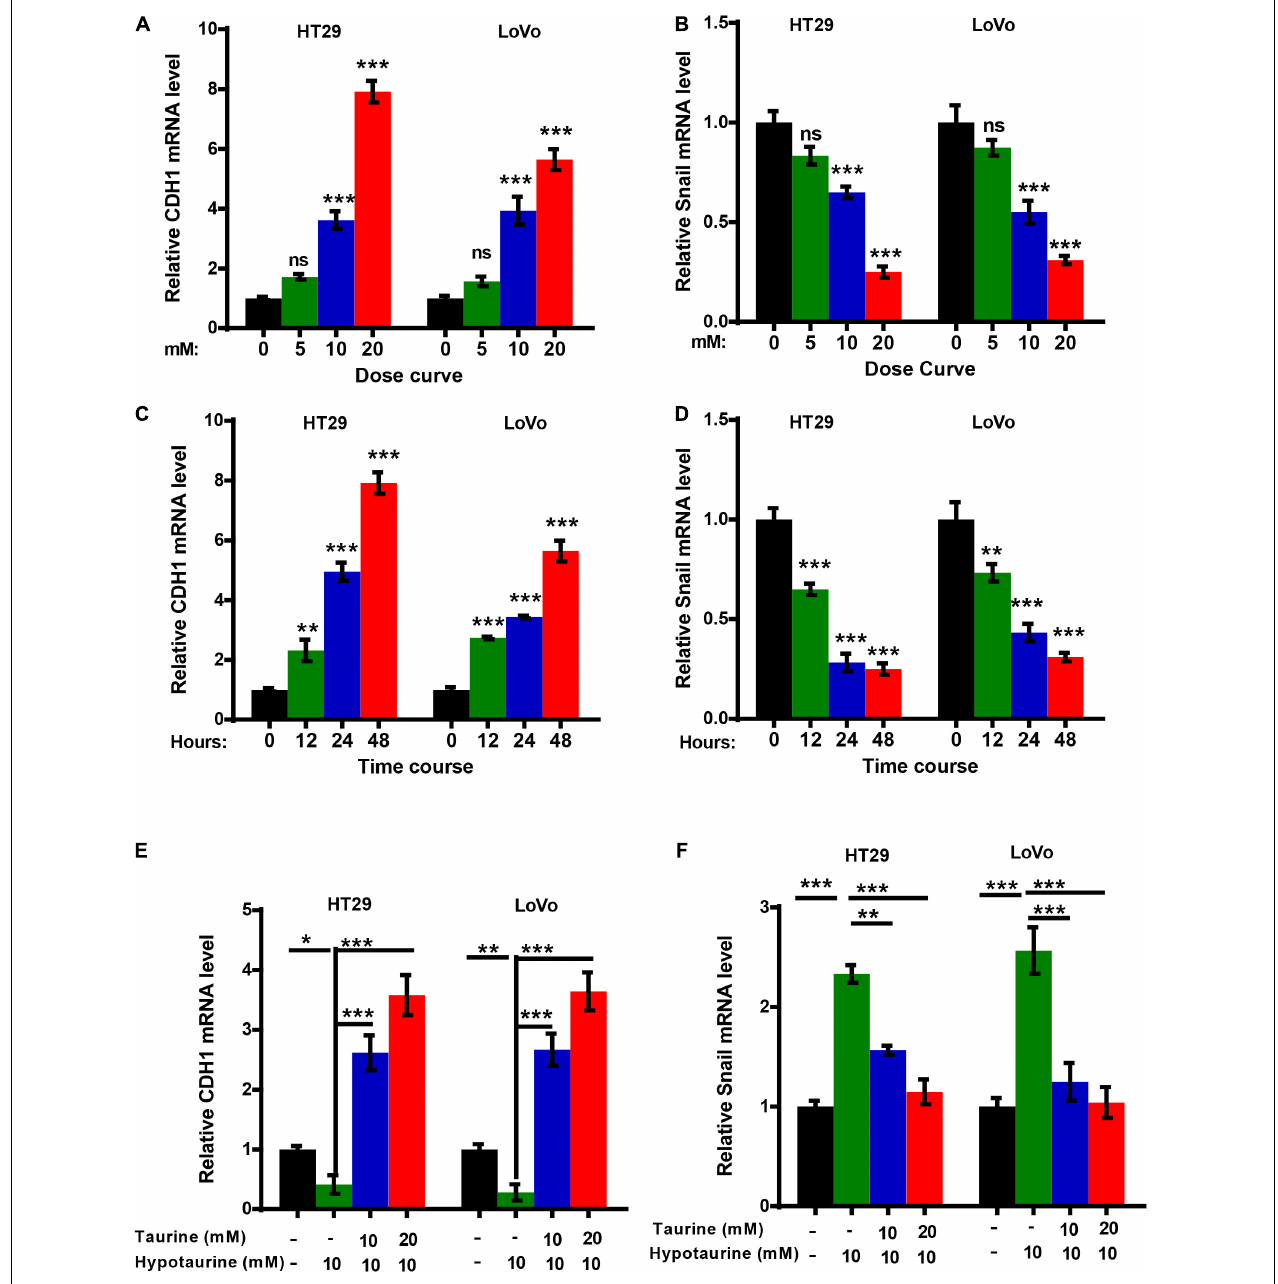
FIGURE 4 | Taurine reverses the promoting effect of hypotaurine on the EMT in CRC cells. (A,B) The dose-effect curve for taurine on EMT related-gene expression in CRC cells was determined by qRT-PCR (means ± SEM) (one-way ANOVA followed by Tukey’s post hoc test, *** P < 0.001). (C,D) The time-effect curve for taurine on EMT related-gene expression in CRC cells was developed using qRT-PCR (means ± SEM) (one-way ANOVA followed by Tukey’s post hoc test, ** P < 0.01, *** P < 0.001). (E,F) The effects of taurine and/or hypotaurine on EMT markers in CRC cells were measured by qRT-PCR (means ± SEM) (one-way ANOVA followed by Tukey’s post hoc test, * P < 0.05, ** P < 0.01, *** P <